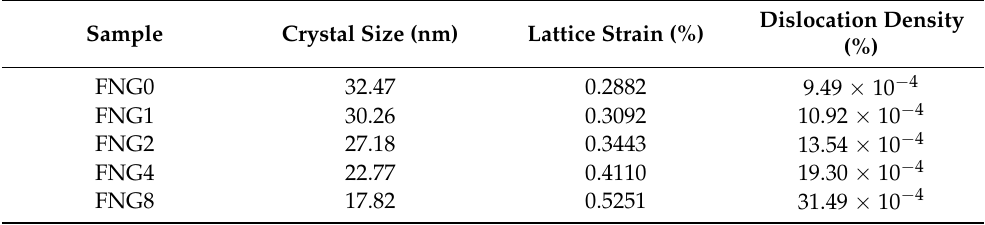
Table 4. The effect of added hybrid reinforcements on the crystal size, lattice strain and dislocation density of the prepared